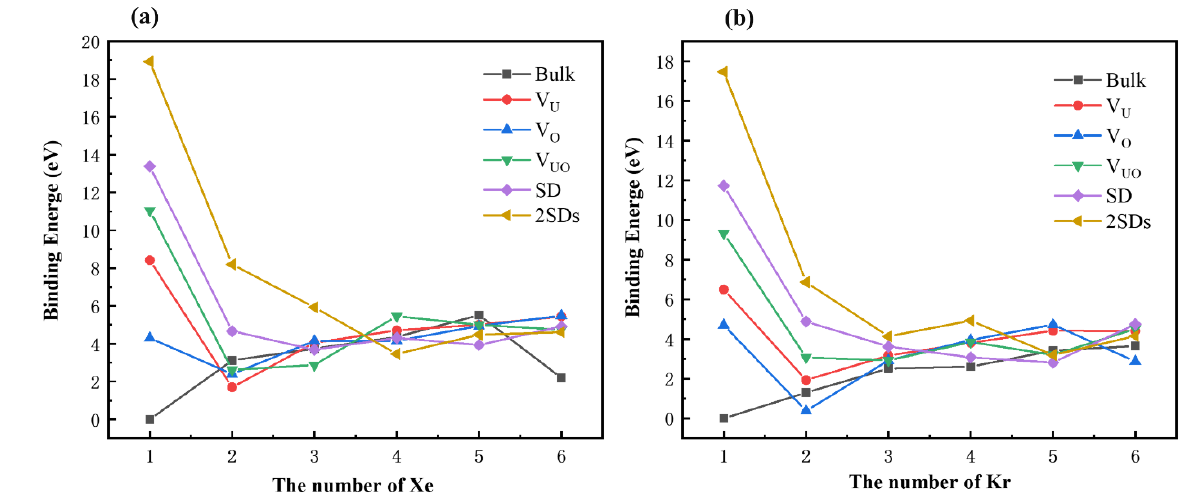
Figure 3. The binding energy (eV) of ( a ) an additional Xe atom and ( b ) an additional Kr atom to a cluster as a function of the number of Xe or Kr atoms in the formed cluster.